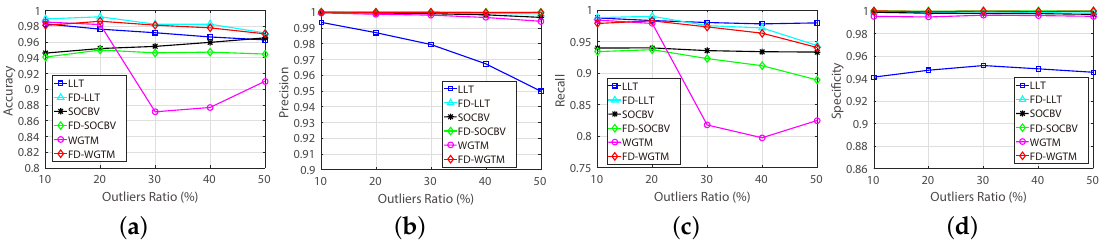
Figure 12. Automatic evaluation results of the three algorithms on datasets with various outliers’ ratio (ratio of false-matches). ( a ) Accuracy. ( b ) Precision. ( c ) Recall. ( d ) Specificity.